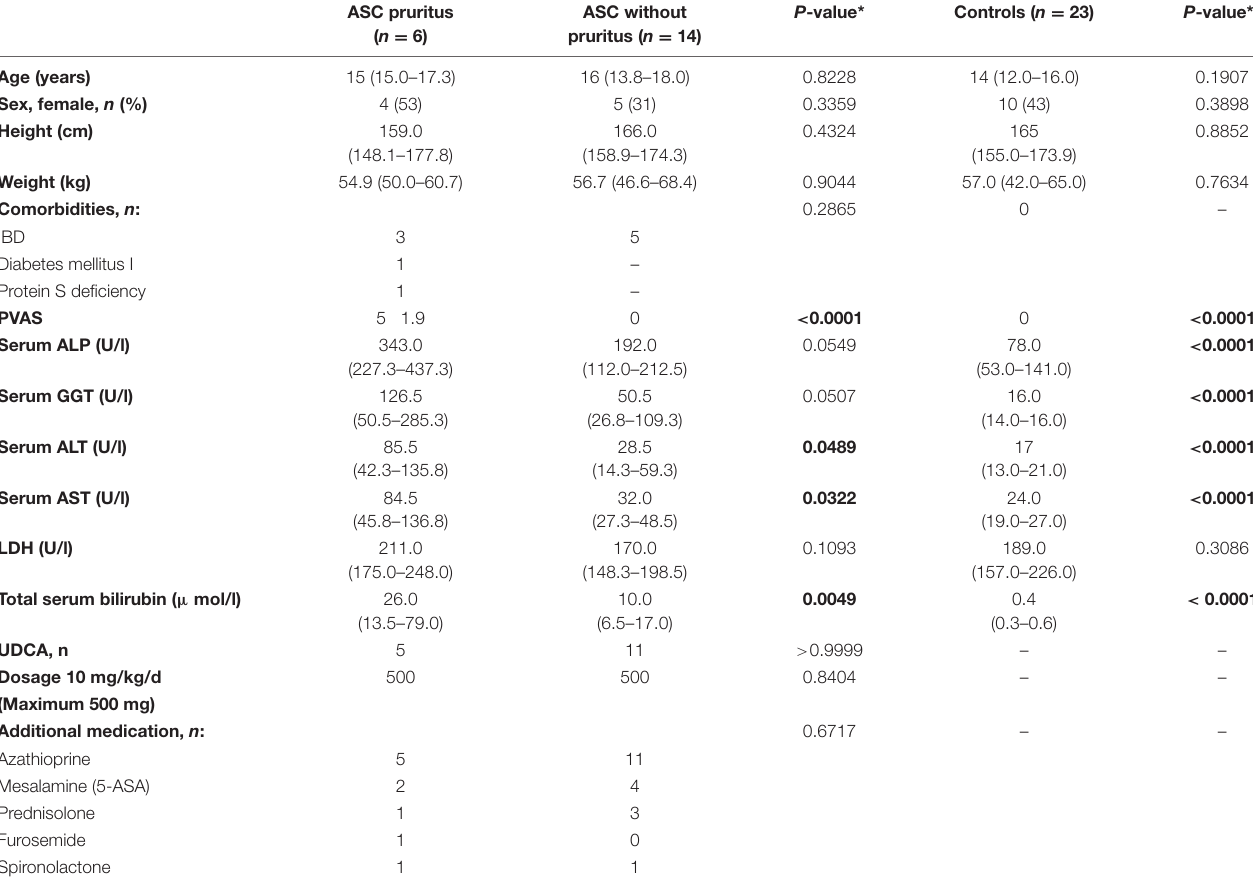
TABLE 2 | Demographic data and biochemical characteristics of ASC patients with and without pruritus and controls.